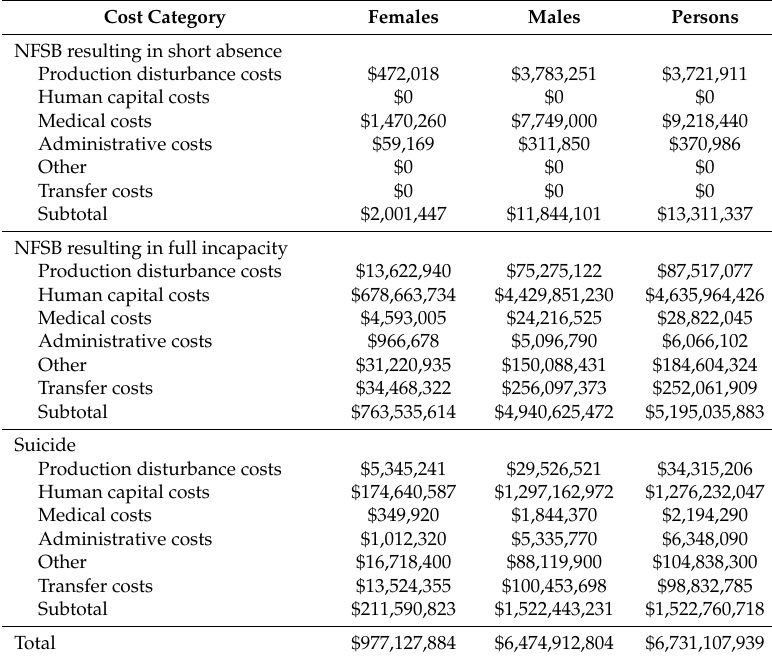
Table 6. Total cost of suicide and NFSB by gender,